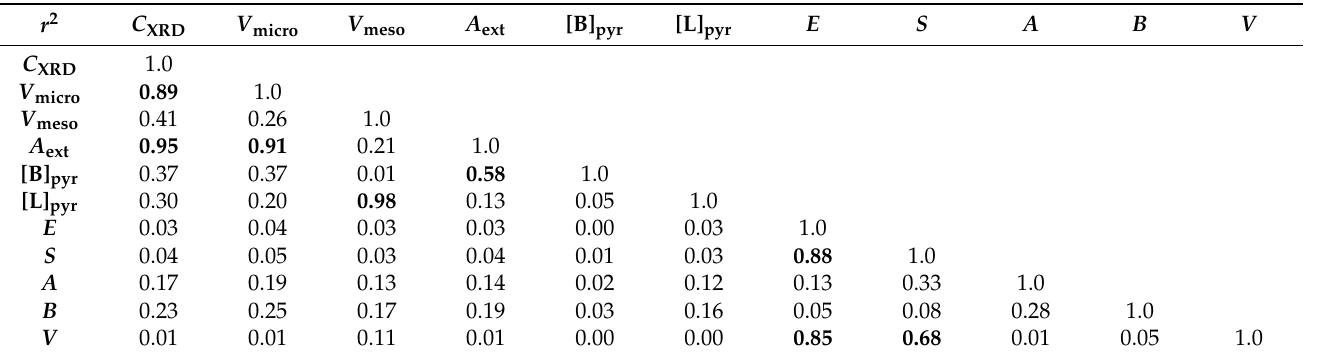
Table 5. Descriptors’ correlation matrix